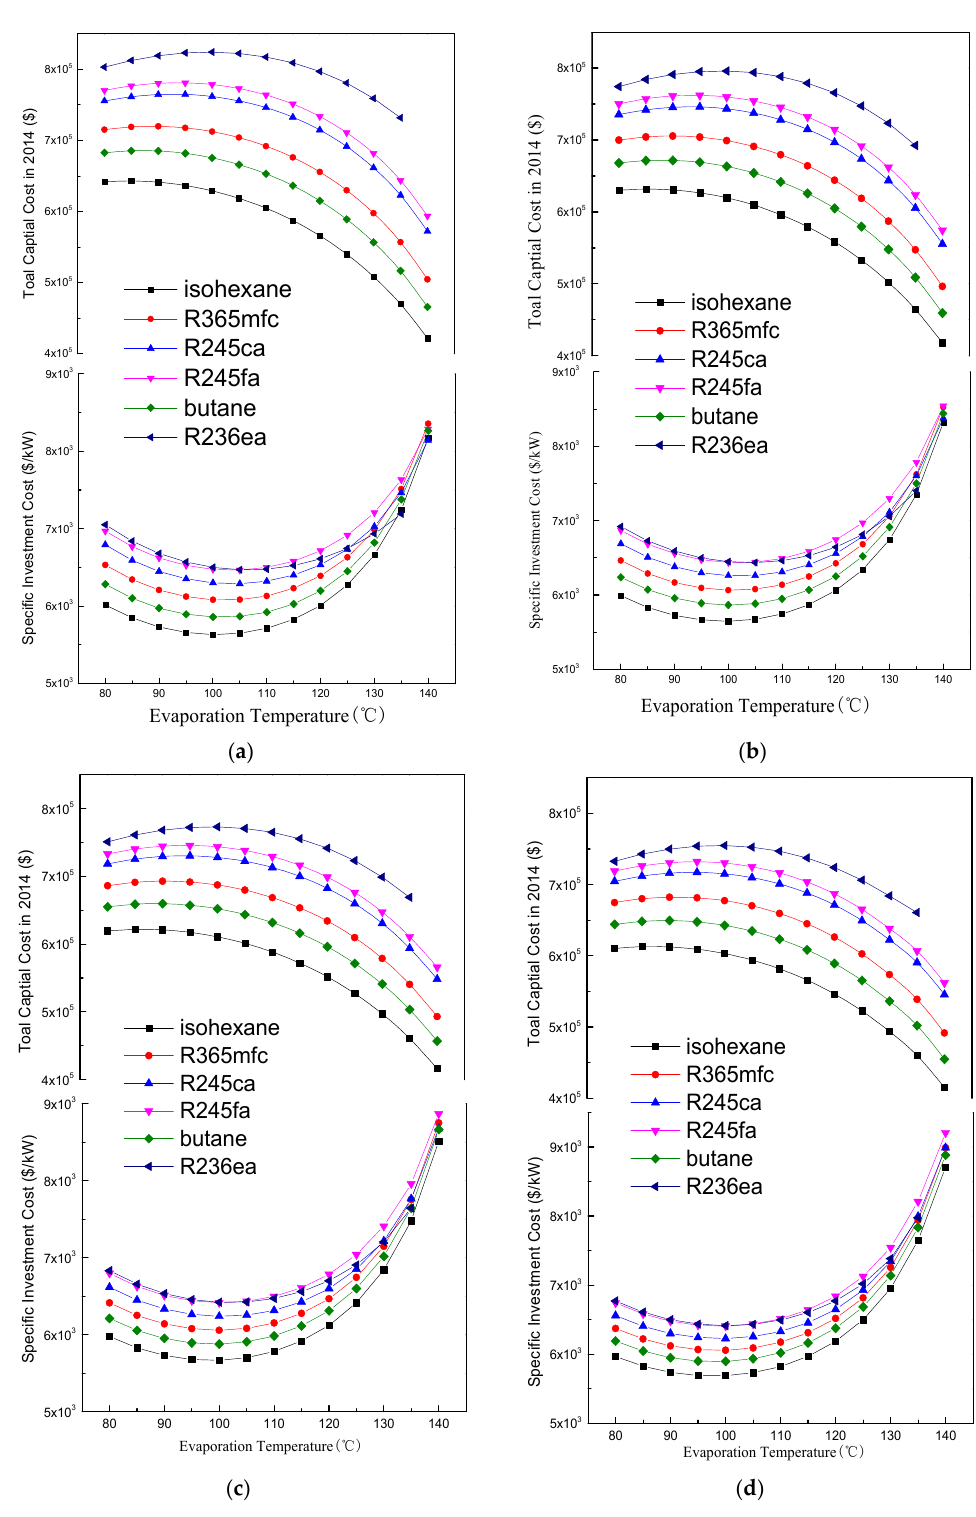
Figure 10. Variations of total capital cost in 2014 and specific investment cost with evaporation temperature at four different degrees of superheat conditions: ( a ) 0 °C degree of superheat; ( b ) 5 °C degree of superheat; ( c ) 10 °C degree of superheat; and ( d ) 15 °C degree of superheat.